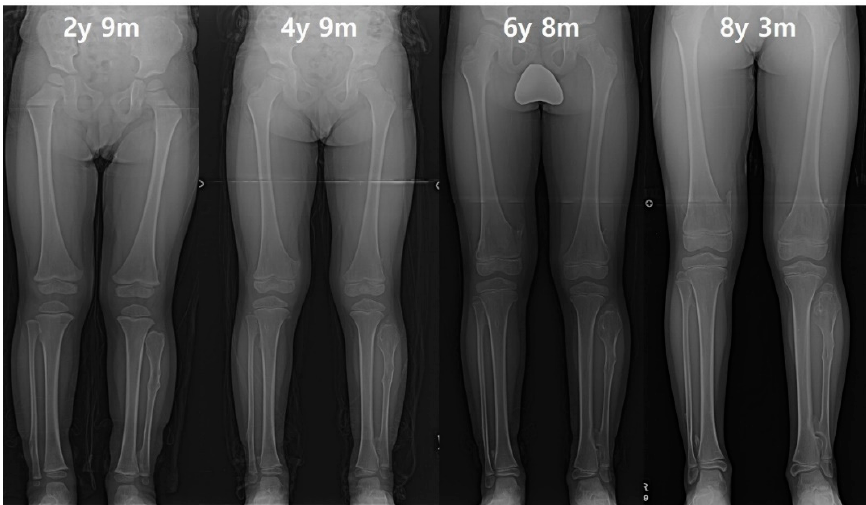
Figure 4. The serial radiographs of a male patient demonstrated progression of valgus deformity on the left ankle. Despite exostoses in bilateral legs, valgus angulation of the left ankle accompanied by shortening of the fibula was observed, while the neutral alignment was maintained on the right ankle. In the last measurement, the left tibial length was also about 9 mm shorter than the right tibia.